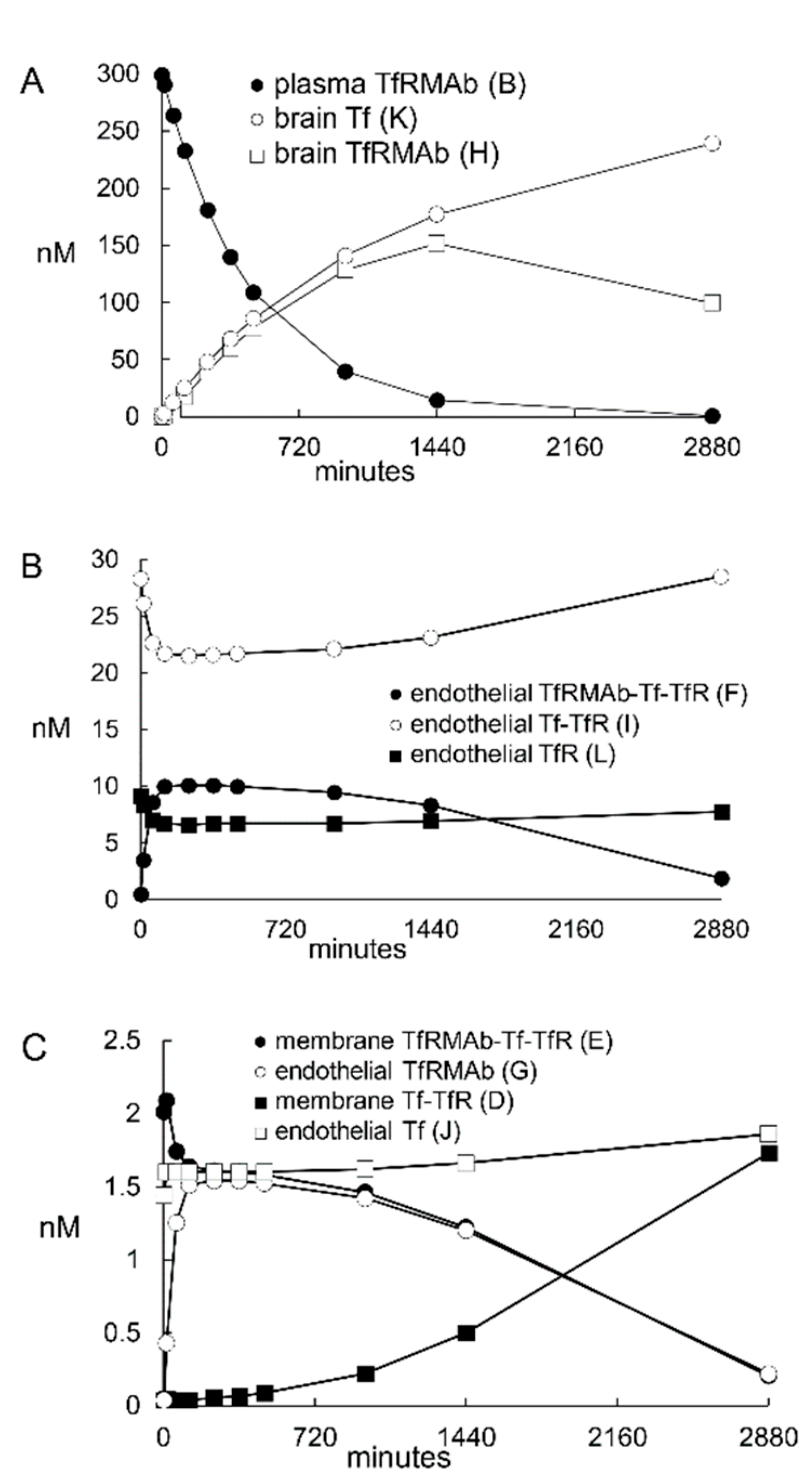
Figure 4. The concentration of the TfR model variables B(t) , K(t) , and H(t) ( A ), variables F(t) , I(t) , and L ( t ) ( B ), and variables E ( t ), G ( t ), D ( t ), and J ( t ) ( C ) is plotted from 0 to 2880 min following the IV administration of an ID of 3 mg/kg of a high affinity (K D = 3.6 nM) TfRMAb. The plot shows the concentrations of variables D ( t ), I ( t ), and L ( t ) approach the initial conditions of D (0) = 2 nM, I (0) = 30 nM, and L (0) = 8 nM at 2880 min after TfRMAb administration.